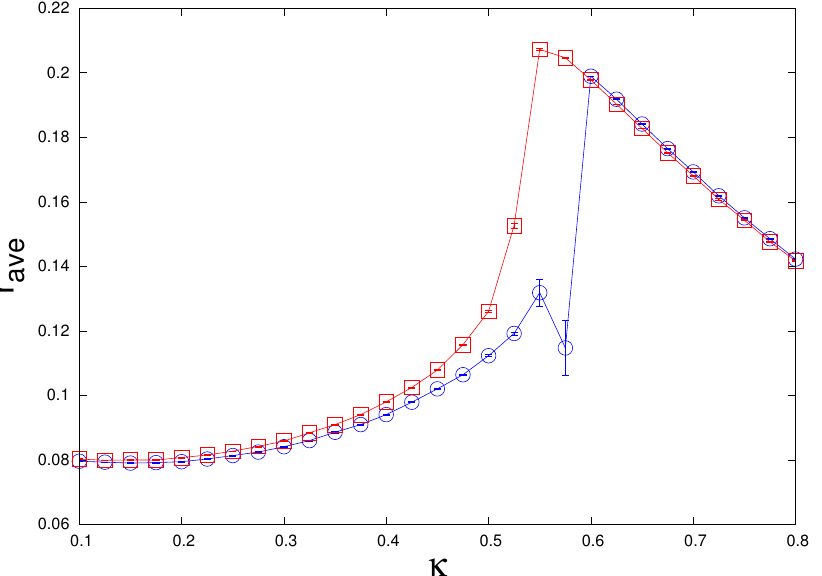
Figure 4. The κ -dependence of fluctuation calculated from persistent diagrams. The square and circle symbols are the results at θ = 0 and π /3 − (cid:101) ,